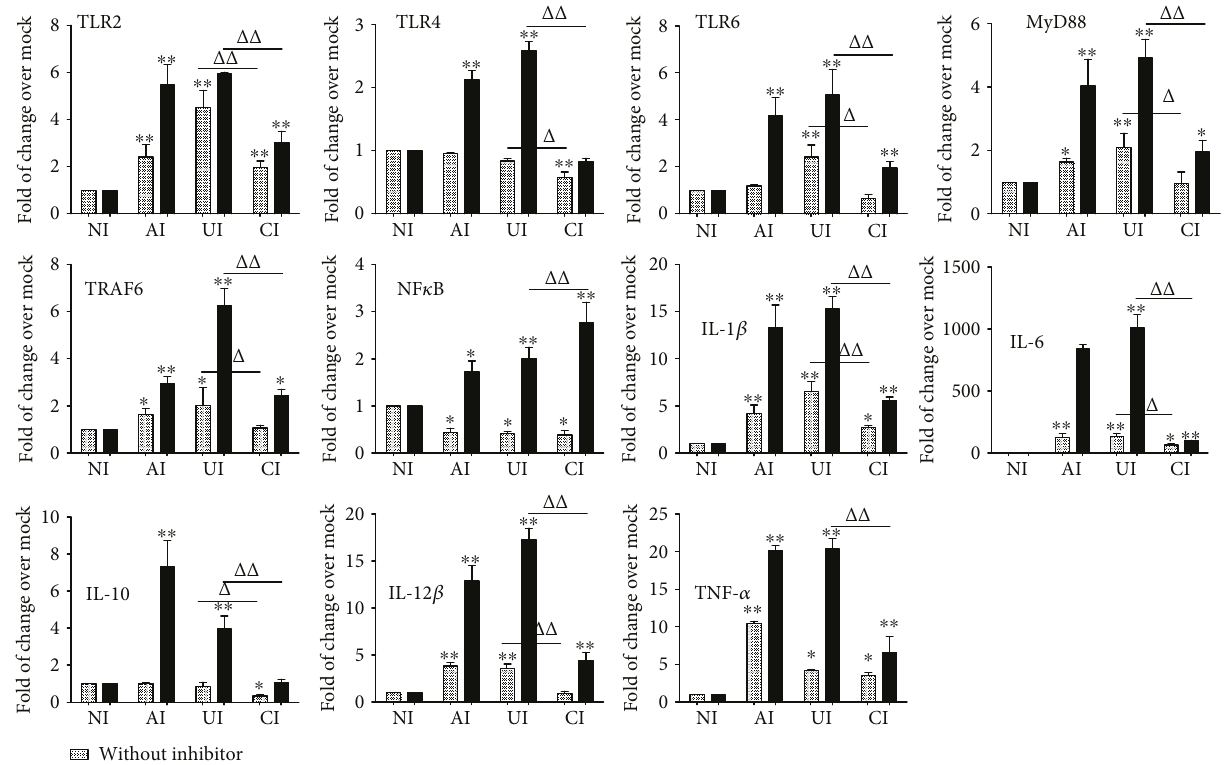
Figure 8: Impact of GSK3 β signaling in U937 cells in response to H37Rv infection. In the presence or absence of GSK3 β inhibitor LiCl, the coculture model of A549/U937 cells was infected with H37Rv mycobacteria from the upper chamber (A549 cells, AI), lower chamber (U937 cells, UI), or both chambers (A549 and U937 cells, CI) at a MOI of 3 for 18 h before the culture medium and U937 cells were harvested for analysis by RT-PCR assay. Inductions of indicated transcripts of U937 cells infected with H37Rv in di ff erent conditions. The data was presented as the fold of changes of indicated transcripts over the noninfected cells. An increased abundance of indicated TLR signaling and cytokines was observed in the presence of GSK3 β inhibitor LiCl, but the trend of a reduction of TLR-mediated in fl